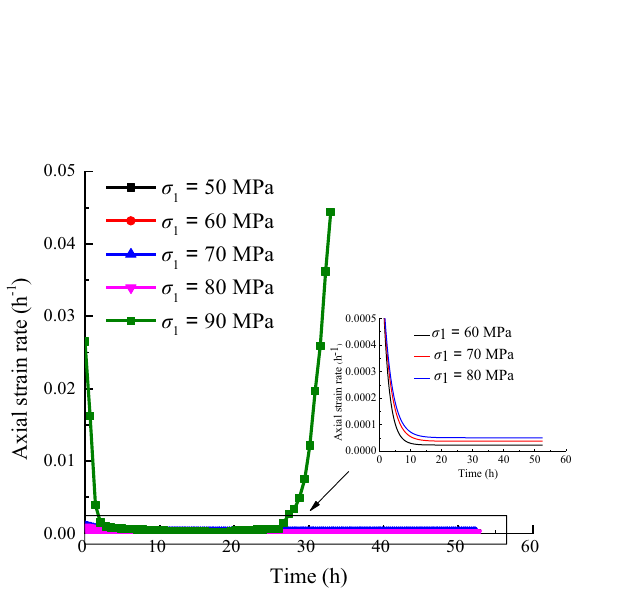
Figure 7. Creep strain rate when σ 3 = 15